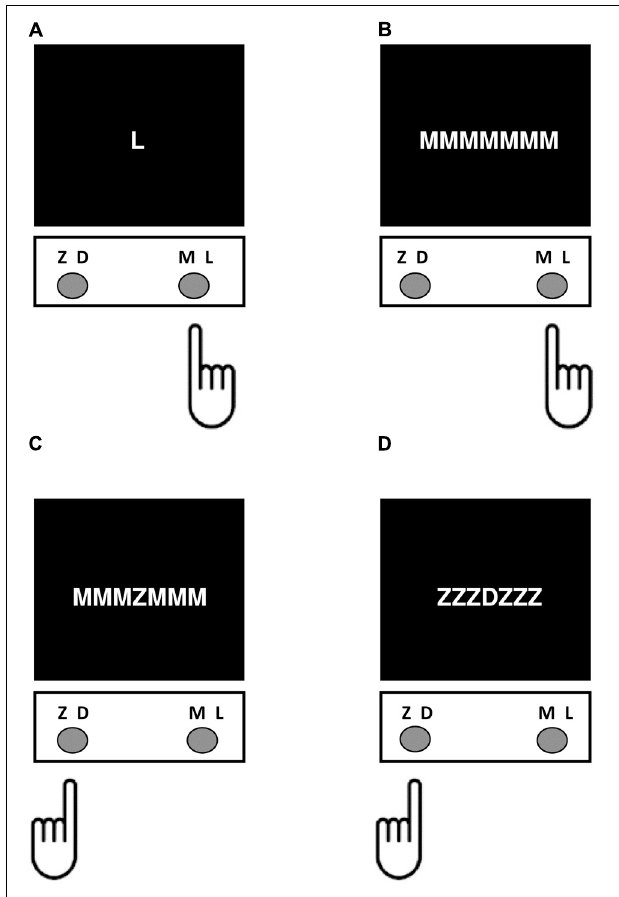
FIGURE 3 | Depiction of the different trial conditions in the Flanker Task. For each trial type, participants responded by pressing the button on the keyboard corresponding to the identity of the letter appearing at central fixation. (A) Control condition – the target letter appeared by itself. (B) Congruent condition – the target letter appeared with three congruent flankers on either side. (C) Incongruent response incompatible condition – the letters flanking the target were mapped onto a conflicting response. (D) Incongruent response compatible condition – the incongruent flanking letters were mapped onto the same